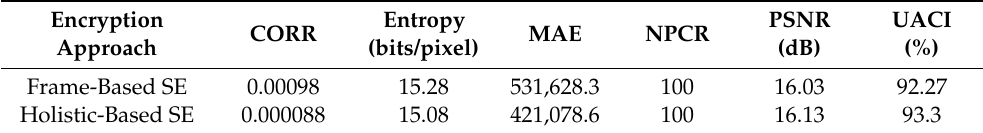
Table 5. Cryptanalysis results of the 69 encrypted